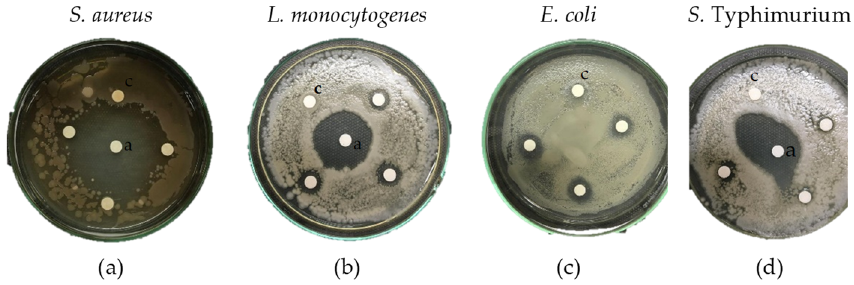
Figure 9. Images of the inhibition halo of the VO(IV)- bis (abietate) solution by the diffusion method tested in triplicate. ( a ) Staphylococcus aureus ; ( b ) Listeria monocytogenes ; ( c ) Escherichia coli ; ( d ) Salmonella enterica Typhimurium . c: Disk with DMSO (negative control). a: disk with chloramphenicol antibiotic (positive control).